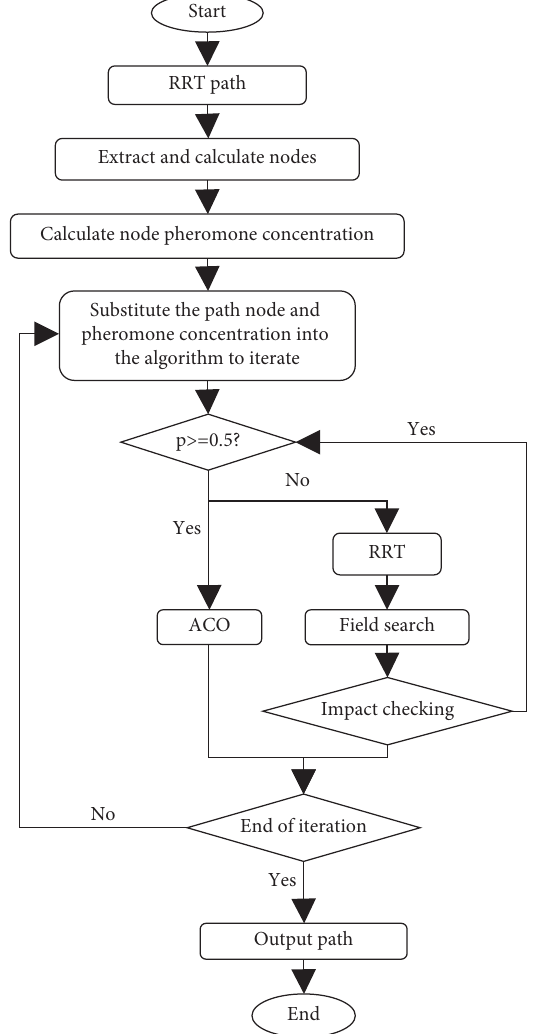
Figure 3: Flowchart of improved RRT